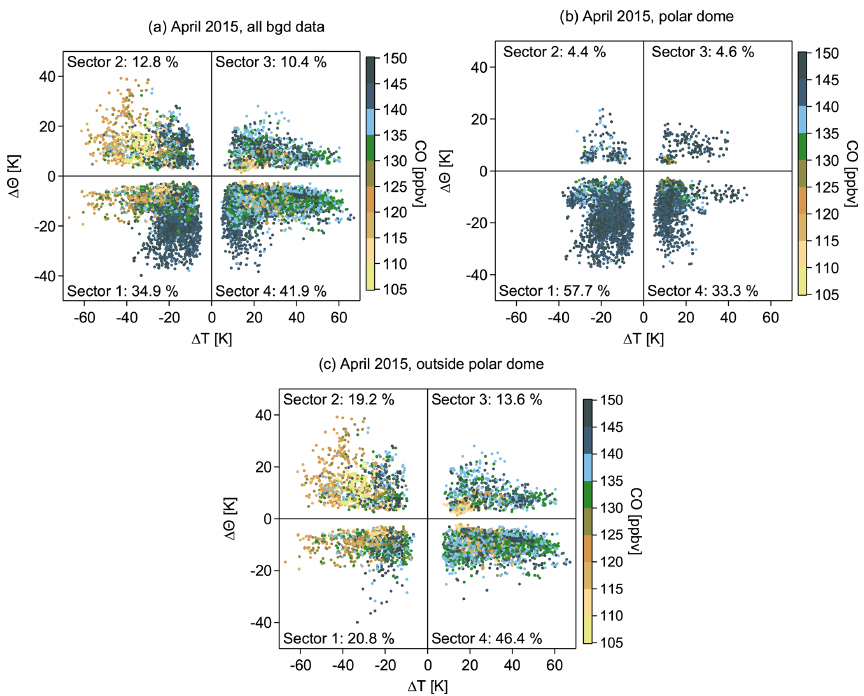
Figure 11. Phase-space diagram illustrating the maximum absolute change in temperature ( (cid:49)T ) and potential temperature ( (cid:49)(cid:50) ) relative to the time of the measurement for April 2015. The color code denotes the CO mixing ratio at the time of the measurement. Panel (a) shows all background data, panel (b) only shows those data corresponding to the polar dome, and panel (c) includes all data points outside the polar dome. To separate the different regions the tracer-derived polar dome boundaries are used (see Table